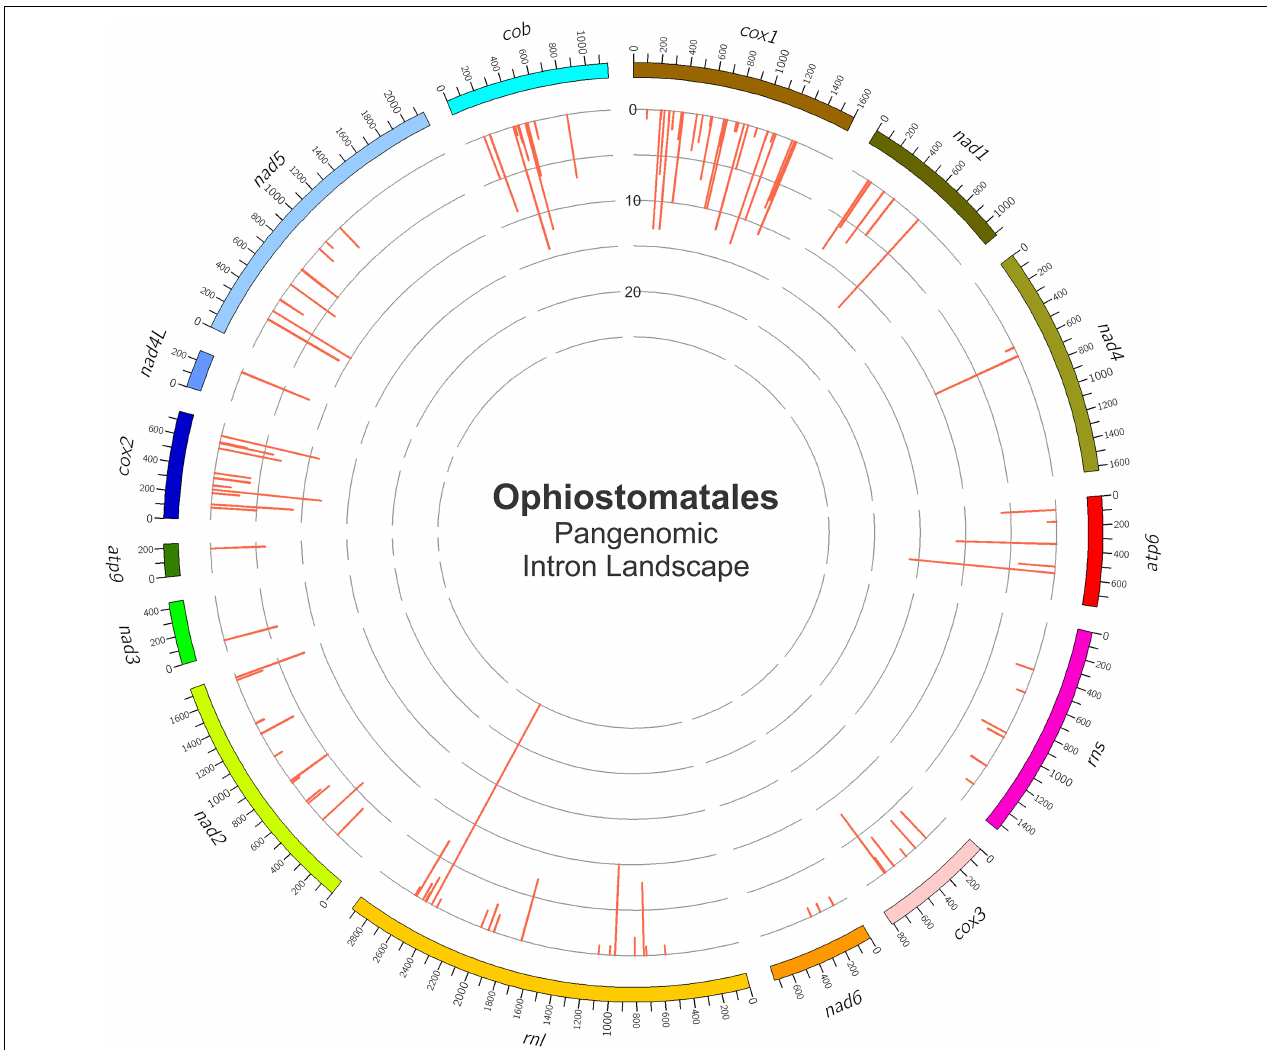
FIGURE 4 | The panintronic landscape for the studied members of the Ophiostomatales. The landscape was generated by Circos and shows all intron insertions sites and their frequencies. More detailed intron landscapes showing intron types, intron-encoded protein types, and introns phasing are shown in Supplementary Figures 1A–D